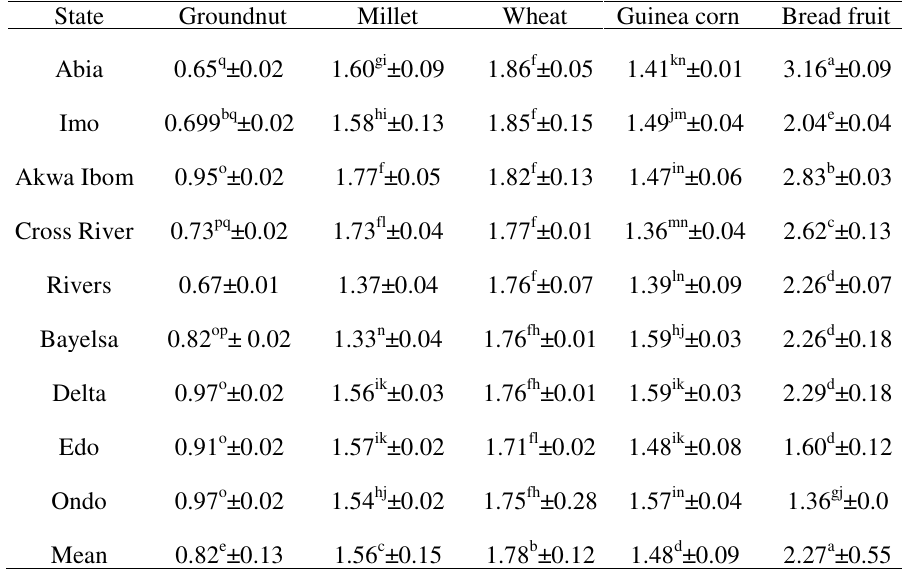
Table 2 . Flavonoid content of grains,